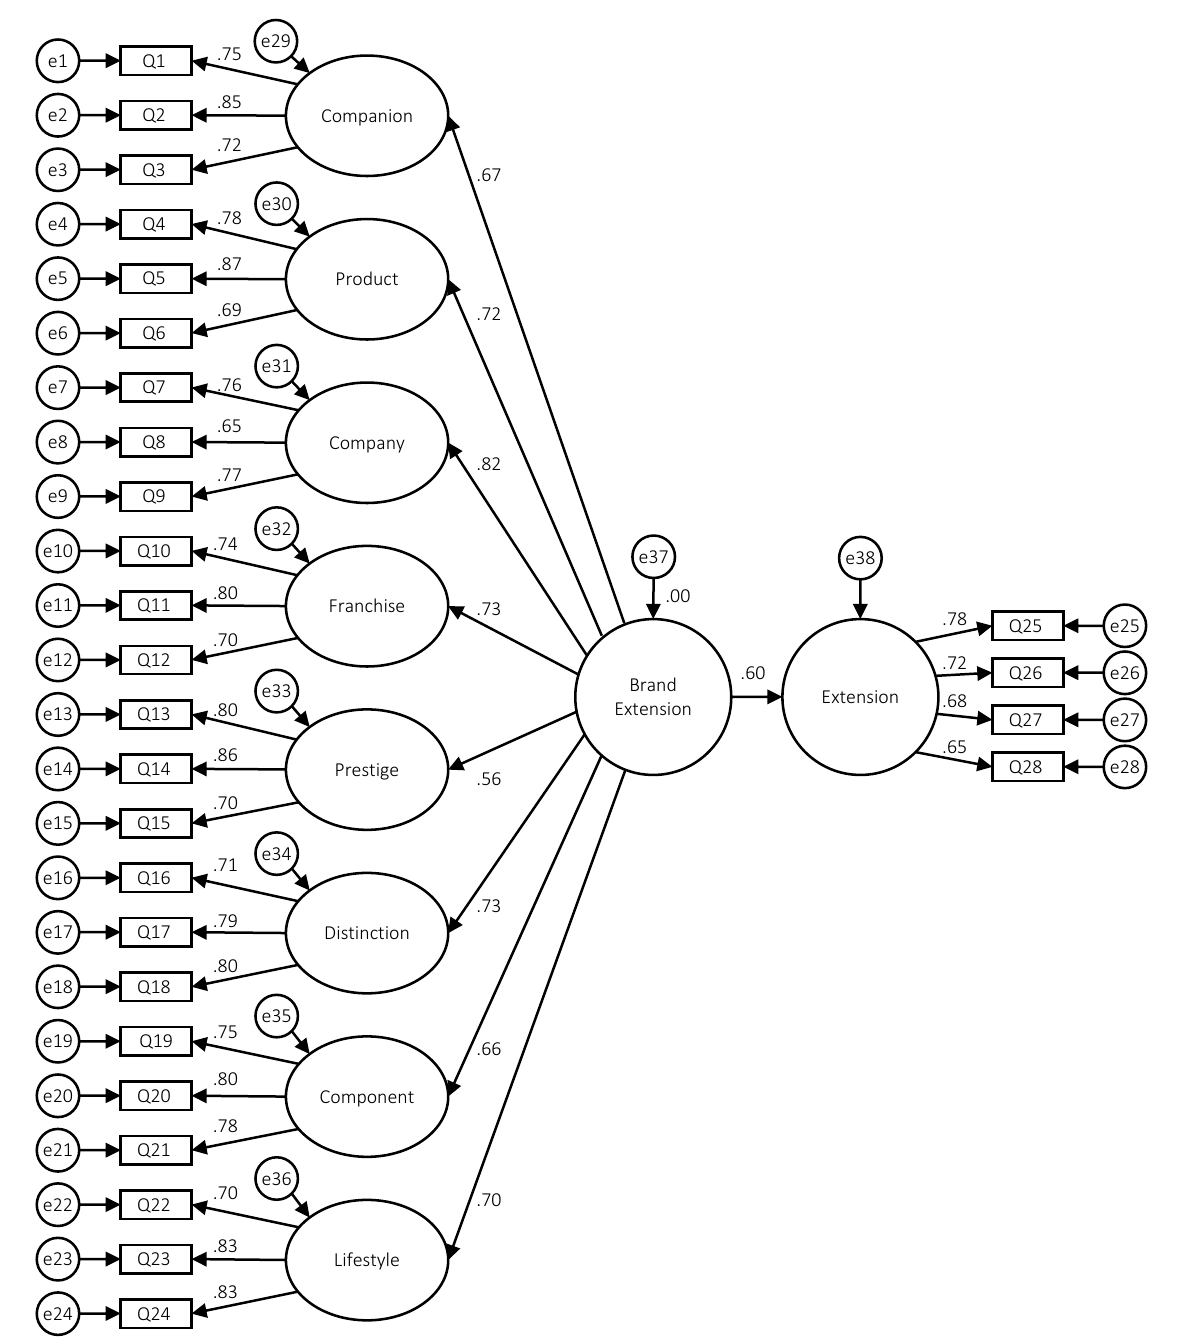
Figure 2. Confirmatory factor analysis for testing the causal